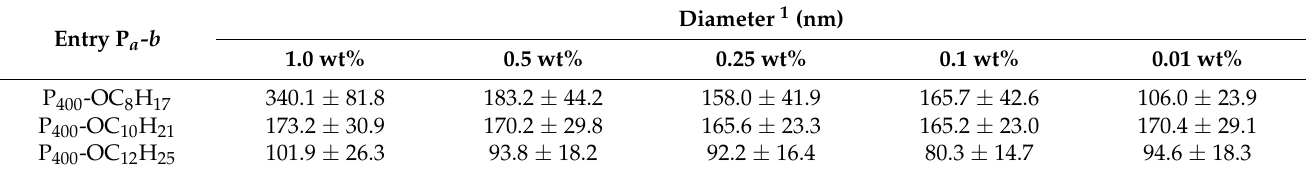
Table 5. Dependence of micelle diameter from the alkyl chain length and polymer concentration.